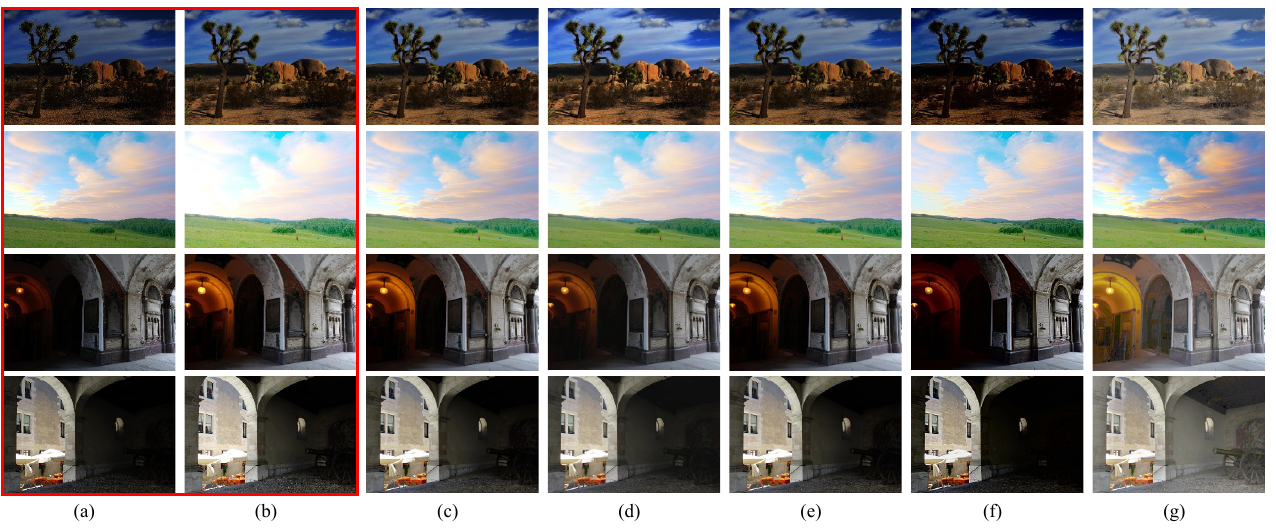
Figure 5. Comparisons of the fusion results using different algorithms, where the two input images had smaller exposure differences. ( a , b ) show the input images squared in red. The fusion results were obtained using ( c ) Kou’s method [8], ( d ) DeepFuse [10], ( e ) Yang’s method [9], ( f ) U2Fusion [13], and ( g ) the proposed